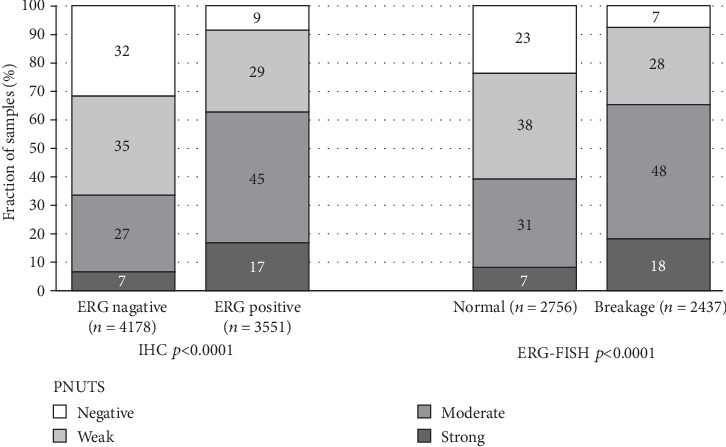
PNUTS staining and ERG status (IHC/FISH).